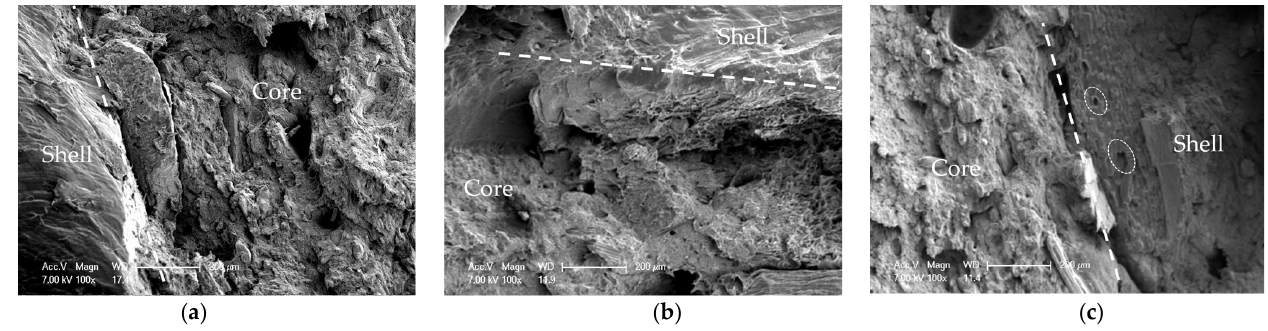
Figure 5. Morphology of fractured surfaces of core–shell structured WPCs. ( a ) CSHDPE; ( b ) CS CA10; ( c ) CSCA25.